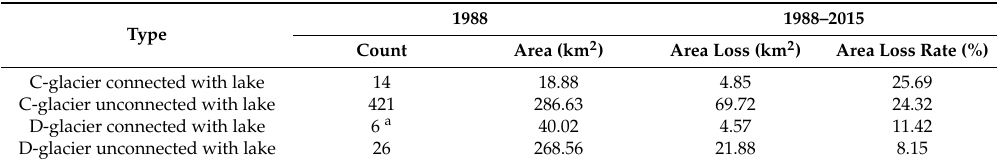
Table 6. Comparison of glacier changes by their connection with or without glacial